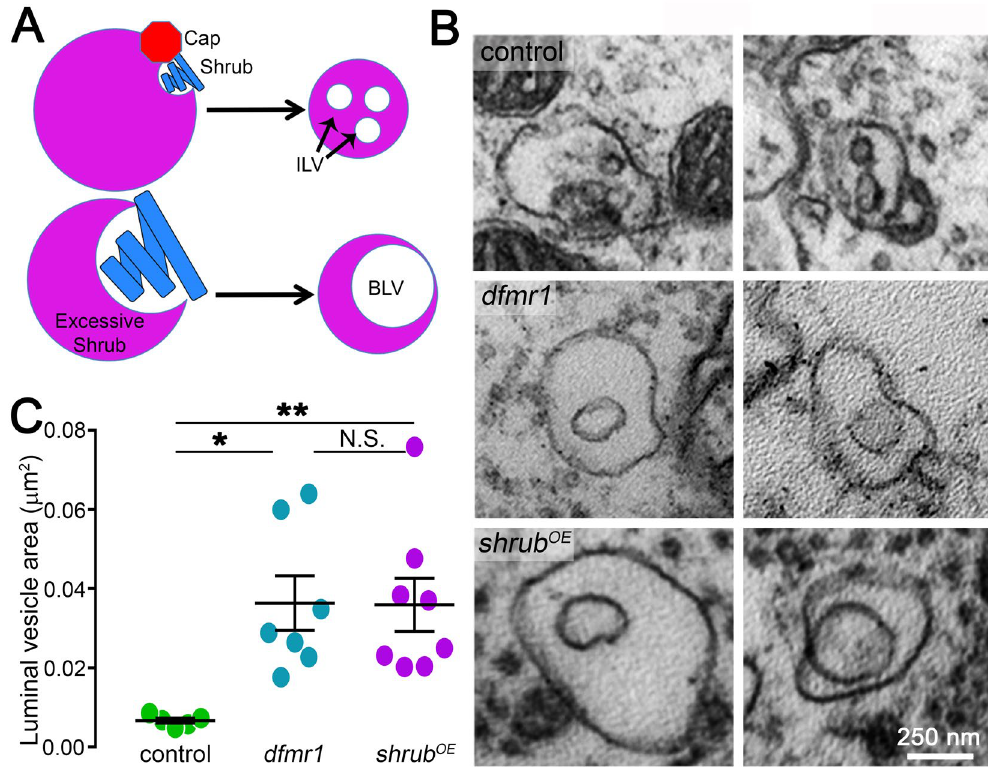
Figure 6. FMRP LOF and Shrub GOF similarly arrest ILV formation in synaptic boutons. ( A ) Schematic depicting how increased Shrub levels impact ILV formation. Top: Proper Shrub levels form spiral protein filaments (blue) that are capped by Vps24 (red octagon) leading to small interluminal vesicle (ILV) formation within MVBs. Bottom: Excessive Shrub levels result in unrestrained filaments (blue), not correctly capped, leading to big luminal vesicle (BLV) formation. ( B ) Representative electron micrographs comparing ILV organelles in transgenic controls ( elav -Gal4/ + ) to enlarged BLV organelles characterizing both the dfmr1 null mutant ( elav -Gal4/ + ; dfmr1 50M ) and shrub over-expression ( shrub OE ) GPF ( elav -Gal4/ + ; UAS-Shrub/ + ). ( C ) Quantification dot plot of luminal vesicle areas in all three genotypes, showing mean ± SEM. Statistics done with one way ANOVA with the Kruskal-Wallis test followed by a Dunn’s multiple comparison test post hoc indicated as N.S. P > 0.05, * P < 0.05 and ** P <